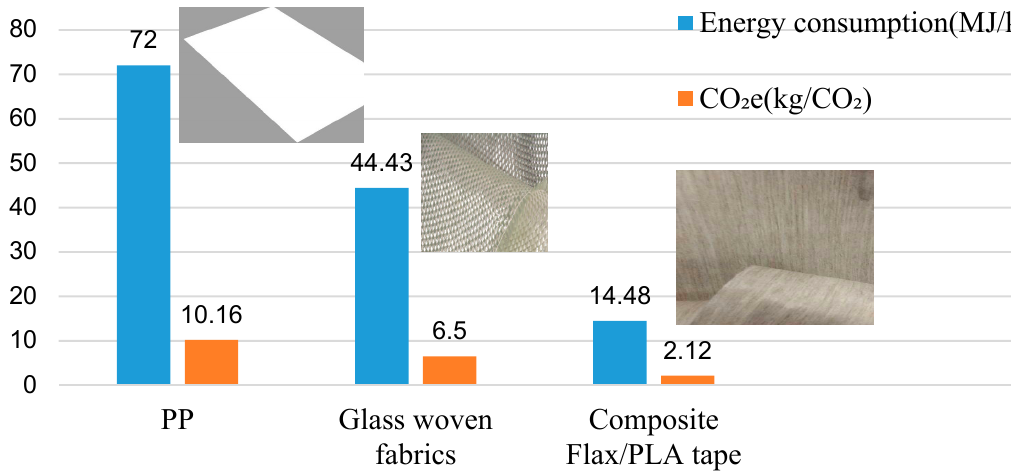
Figure 10. Energy consumption to produce fibre for composite materials.